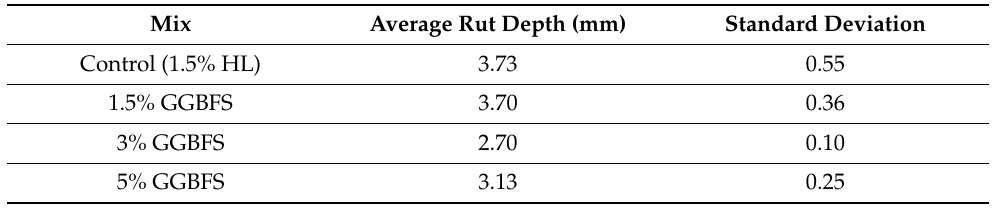
Table 11. Wheel tracking test results.